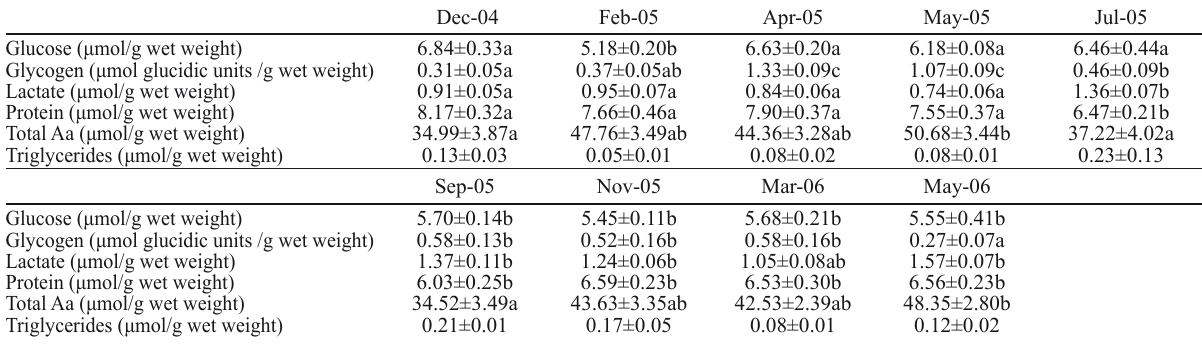
Fig. 3. – Seasonal changes in liver HK (A), FBP (B), G6PDH (C), GDH (D), GOT (E) and G3PDH (F) activities in A. regius specimens cultured in earthen ponds. Further details as in legend of Figure 2. Table 5. – Seasonal changes in muscle metabolite levels in A. regius specimens cultured in earthen ponds. Further details as in legend of Figure